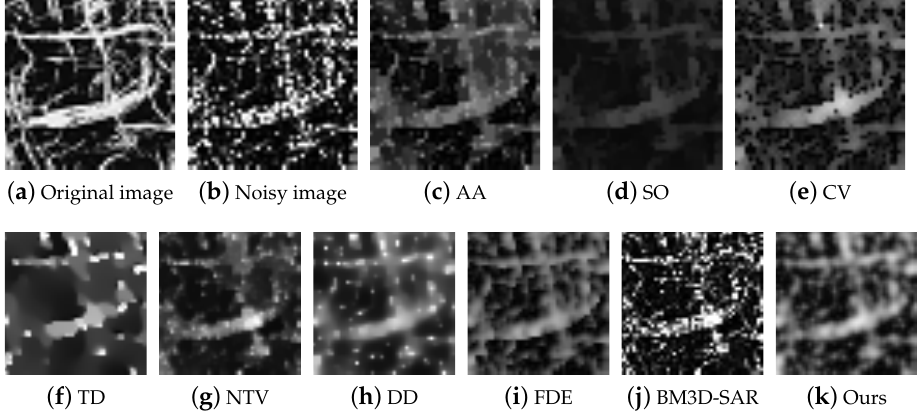
Figure 7. The first zoomed detail of despeckled results on the texture1 image: ( a ) The original image. ( b ) Noisy: L = 1. ( c – k ) Despeckled results.